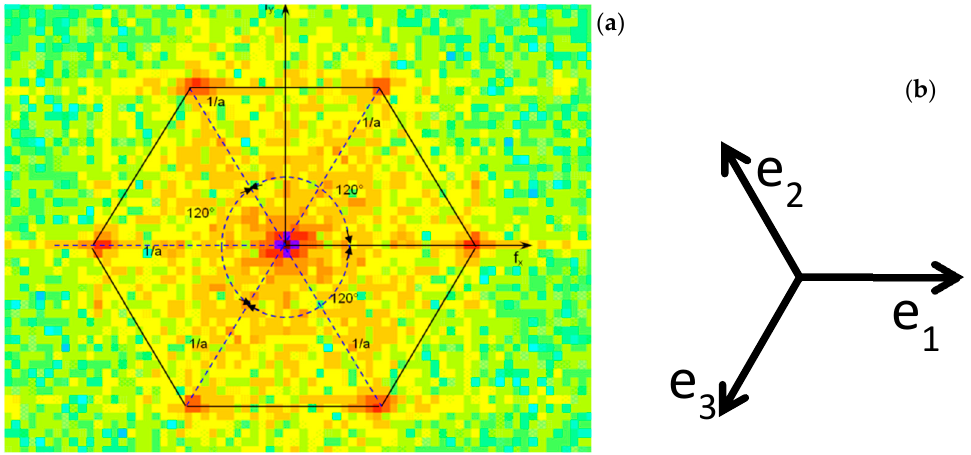
Figure 6. ( a ) FFT of the HRTEM pattern shown in Figure 6a; ( b ) reference system related to FFT.